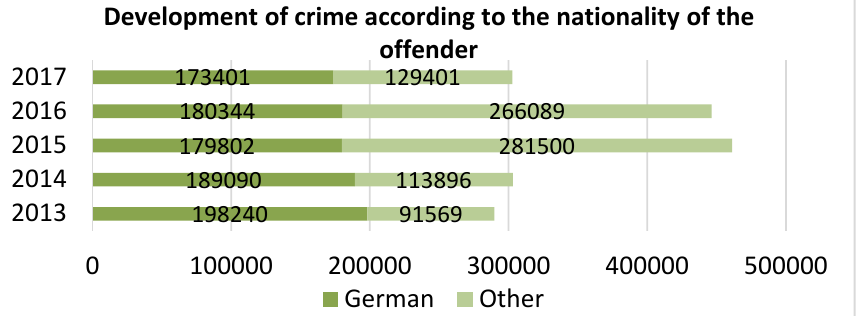
Figure 9. Graph of crime development by nationality of the offender region of Bavaria [adopted from 15]